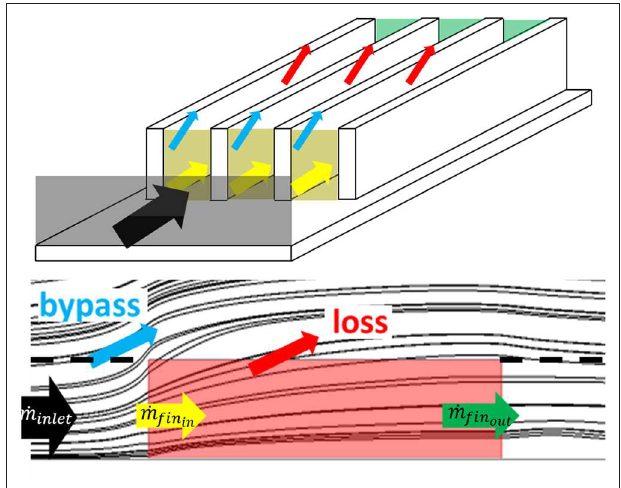
FIGURE 1 | Schematic of surface cooler with depiction of bypass and loss.